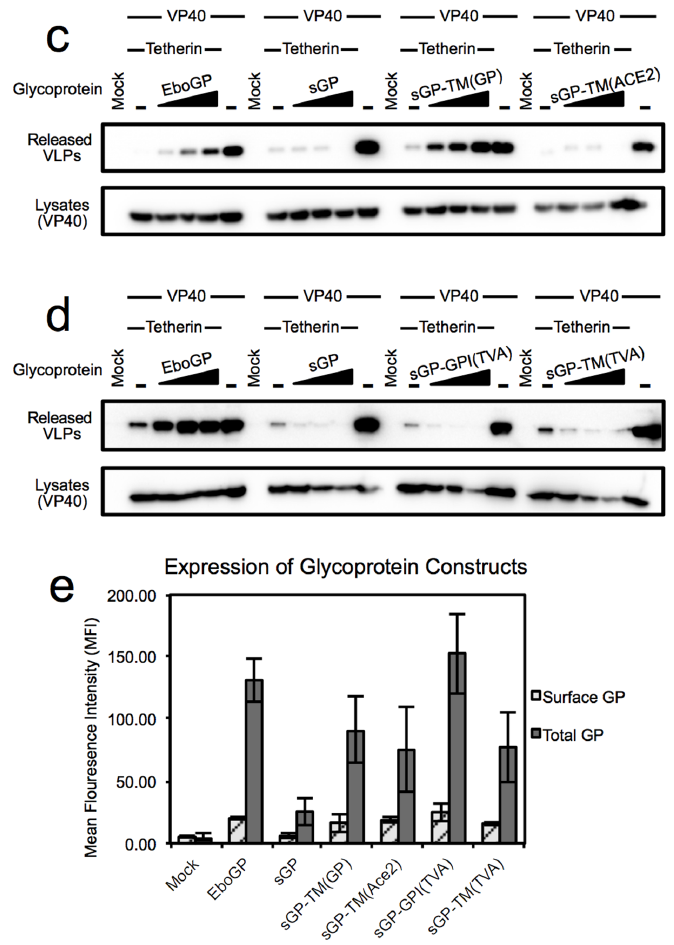
Figure 1. ( a ) A schematic diagram of the constructs used in this study showing the domains of EboGP, sGP, and a chimeric sGP with an appended membrane spanning domain (msd), either a protein transmembrane (TM) domain or a GPI anchor, to the C-terminus; ( b ) Amino acid sequences of the constructs employed, highlighting the C-terminal regions appended to the chimeric